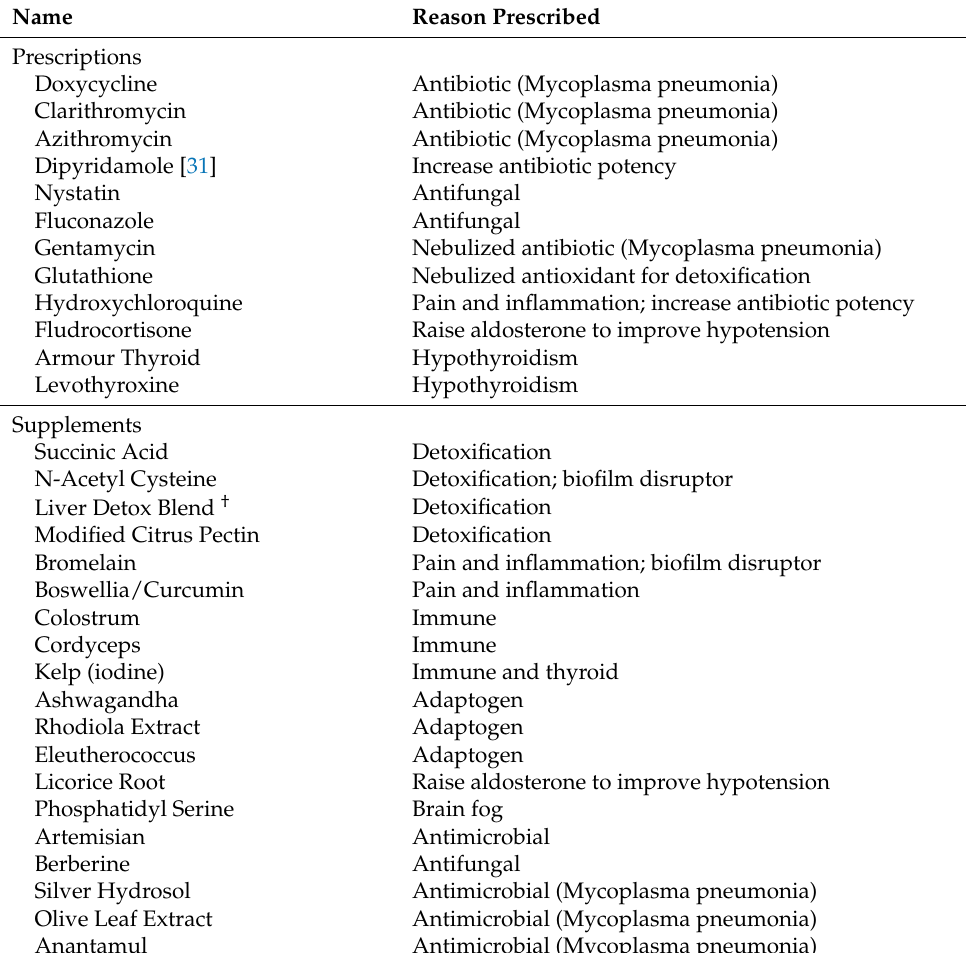
Table 3. Medications Prescribed during Phase 1 of Treatment (September 2013–February